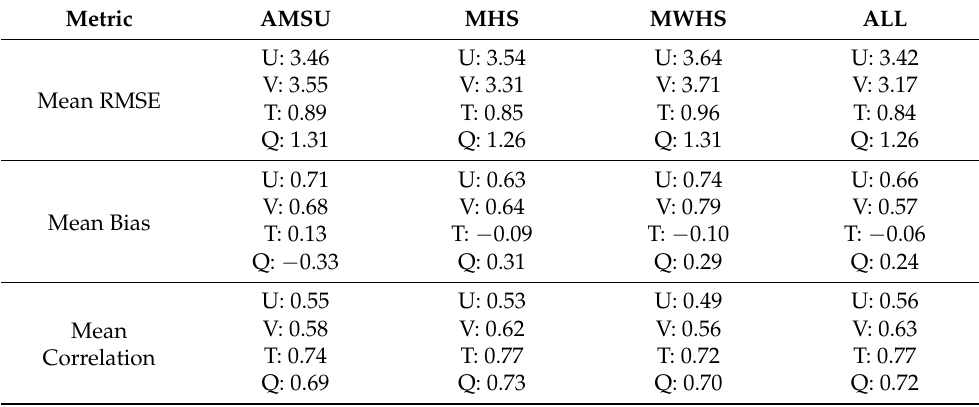
Mean Correlation